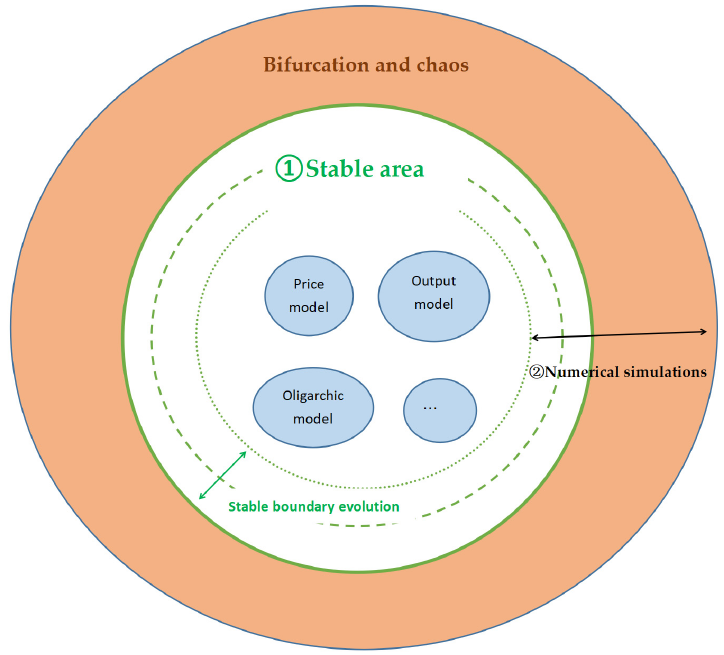
Figure 8. Stability and its evolutionary analysis.